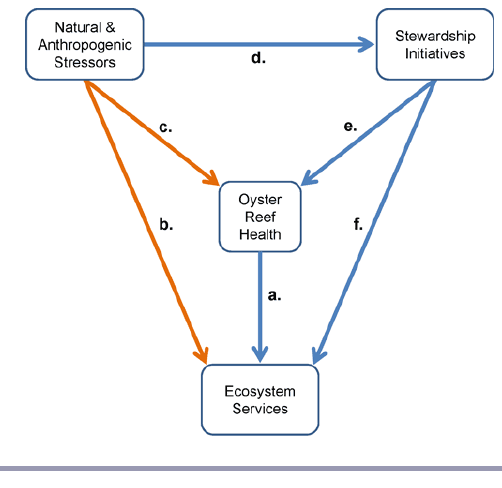
Fig. 1 . Illustration of a coupled social-ecological system involving stressors, stewardship, oyster reef health and ecosystem services. Our study design focused on measuring relationships between societal values and beliefs on ecosystem services (a), problem definition and recognition (b-c), and perceived effectiveness and support for alternatives and stewardship initiatives